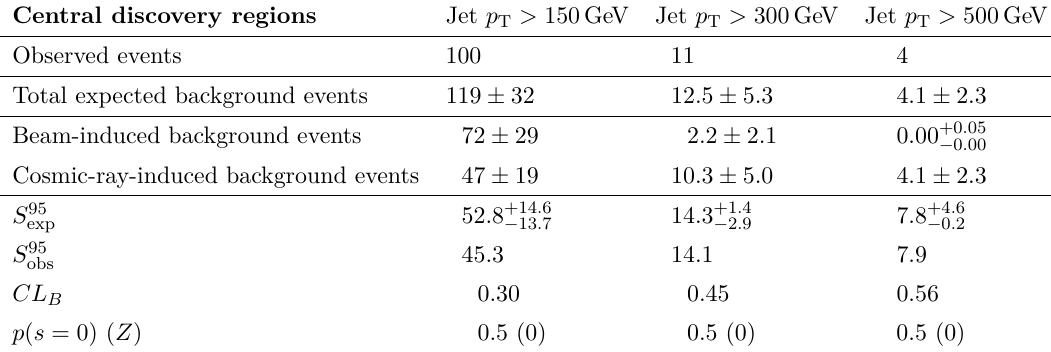
Table 7 . Central (jet | η | < 0 . 8 ) discovery regions in 2018 data. The lower lines of the table show the 95% CL upper limits on the number of signal events ( S 95 ), the 95% CL upper limit on the number obs of signal events given the expected number (and ± 1 σ excursions of the expectation) of background events ( S 95 ), the CL value, i.e. the confidence level observed for the background-only hypothesis, B exp and the discovery p -value ( p ( s = 0) ). The p -value is reported as 0.5 if the observed yield is smaller than the predicted. Inclusive discovery regions Jet p T > 150 GeV Jet p T > 300 GeV Jet p T > 500 GeV Observed events 221 Total expected background events 208 ± 50